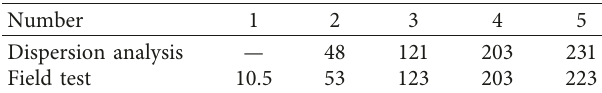
Figure 13: Dispersion curves of the power tunnel modeled as a hollow cylinder shell by the PiP model. Table 1: The dispersion analysis of the power tunnel mode fre- quency distribution and comparison with the field test results.